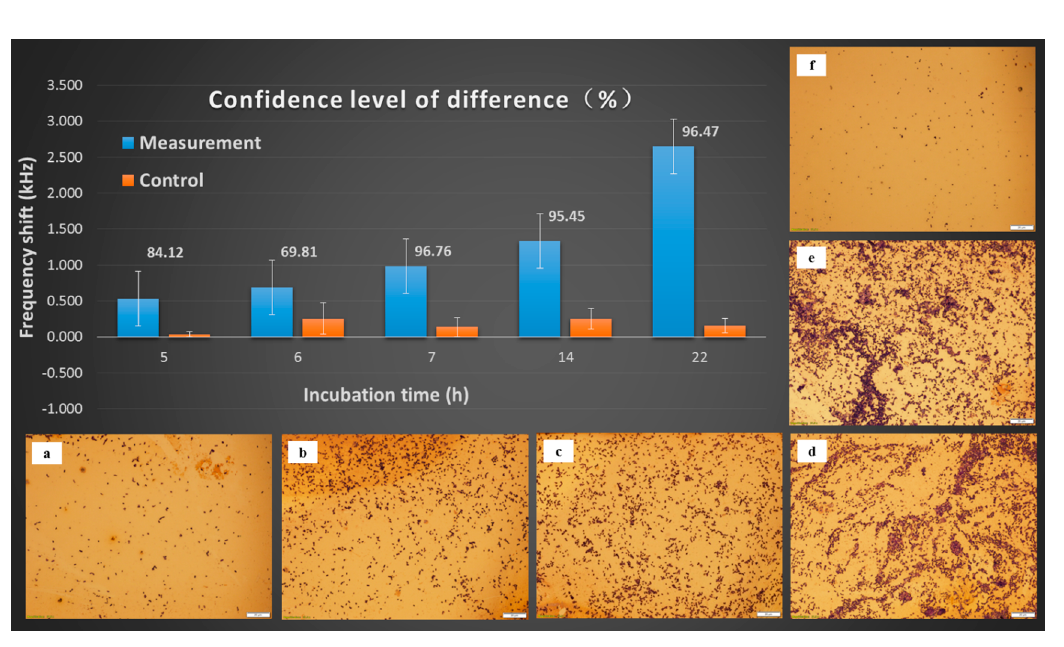
Figure 4. Resonant frequency shifts and sensor surface micrographs (scaleplate 20 μ m) for measurement and control sensors placed in the Salmonella suspensions after different incubation times in LB broth: ( a ) measurement, 5 h; ( b ) measurement, 6 h; ( c ) measurement, 7 h; ( d ) measurement, 14 h; ( e ) measurement, 22 h; ( f ) control.